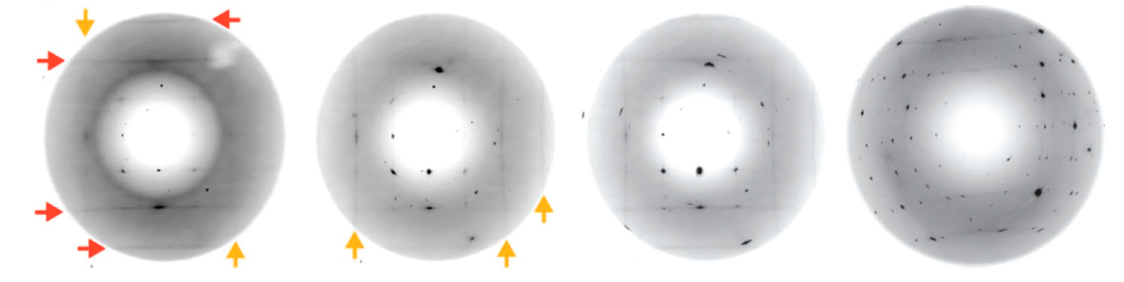
Figure 5. Single-crystal diffuse scattering pattern from a KNbO 3 single-crystal. The red and orange arrows indicate the diffuse scattering lines in the (010) and (100) reciprocal lattice plane, respectively. The {100} diffuse scattering lines became fainter with increasing pressure of 4.3 GPa, 6.3 GPa, 12.1 GPa (left-to-right), and finally disappeared at applied pressure of 21.8 GPa (extreme right). After Ravy et al. [56] Reprinted from reference [56] DOI: 10.1103/PhysRevB.99.117601, with permission from the American Physical Society.